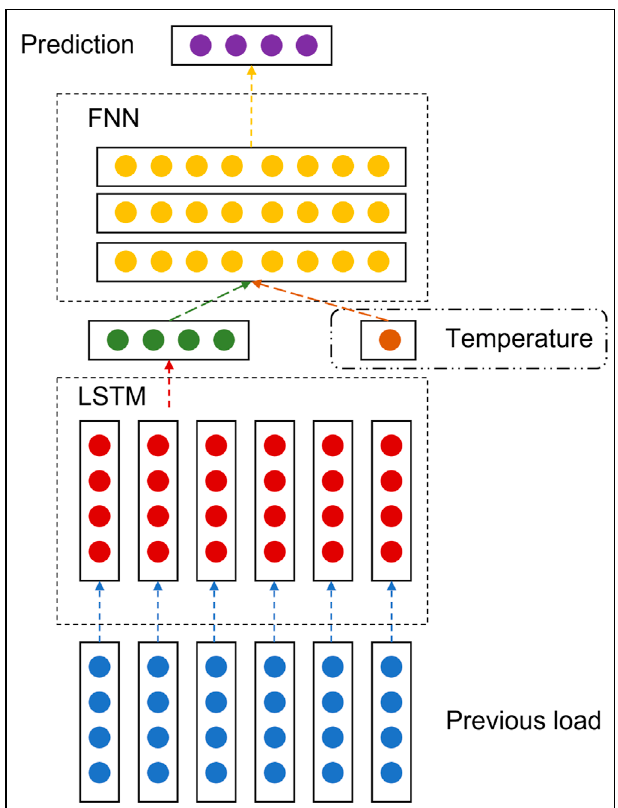
FIGURE 4 | Overview of the architecture of the LSTM-FNN used in this article; the double-dot-dash line around the temperature means participation or nonparticipation of temperature